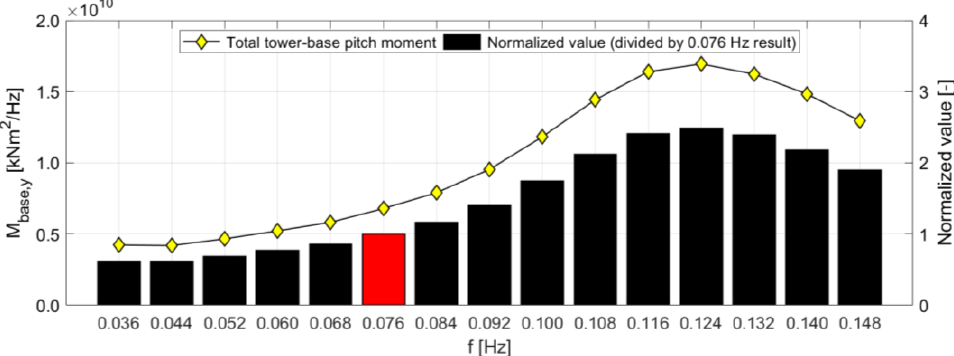
Figure 10. Total tower-base pitch moment and normalized value per wave peak frequencies.